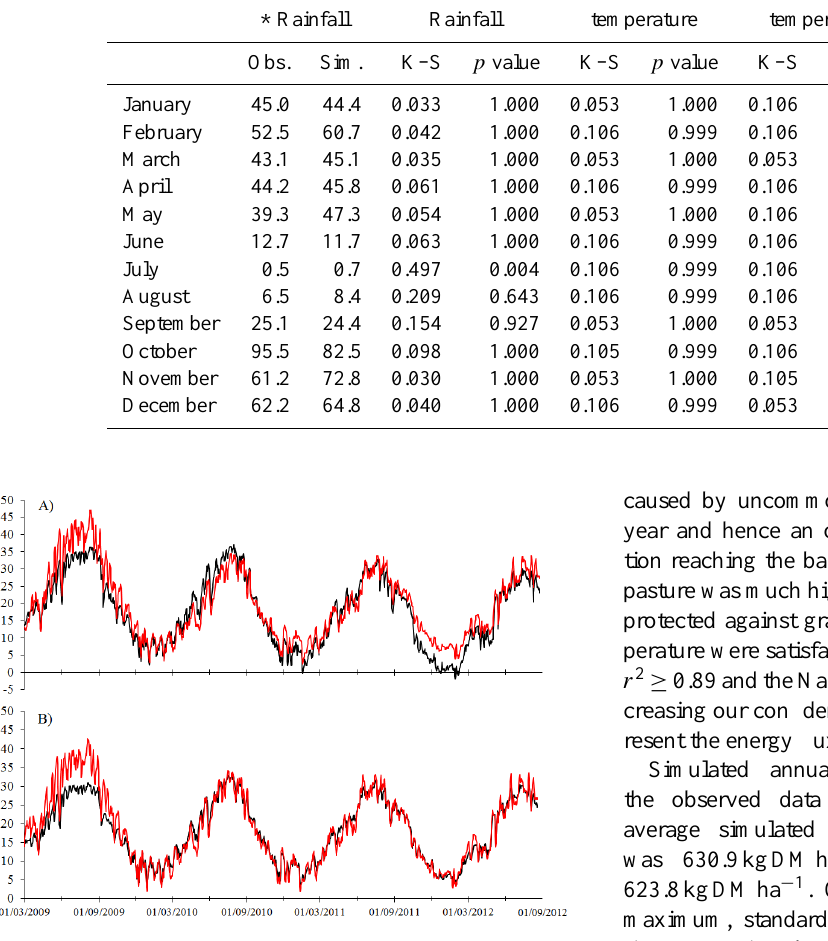
Table 3. Goodness-of-fit between observed and simulated weather data. K–S: Kolmogorov–Smirnov test; *: Example data: Obs.: Observed average values from the study catchment (2000–2012); Sim.: Simulated average values for 300years.